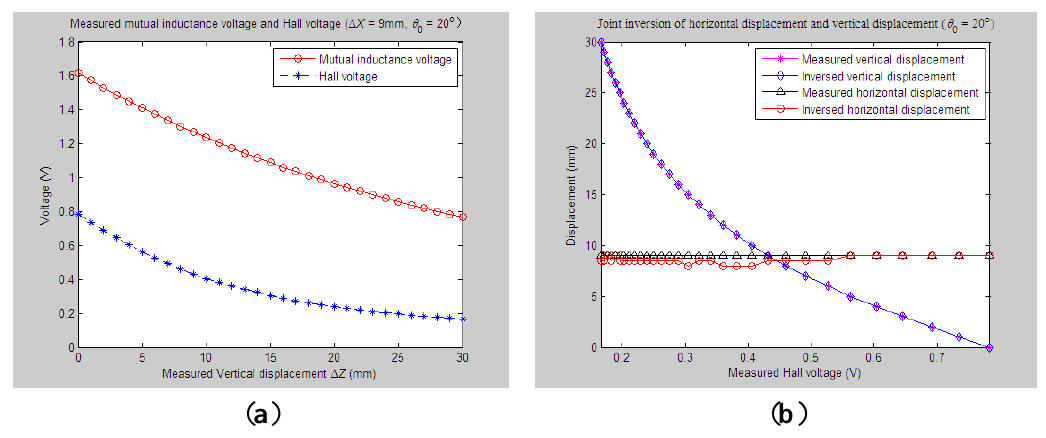
Figure 13. Horizontal and vertical displacement joint inversion results when measured Δ Z are changed, while measured Δ X remain stable ( θ 0 = 20°, Δ X = 9 mm). ( a ) Measured mutual inductance voltage and Hall voltage; ( b ) inversed horizontal and vertical displacements.